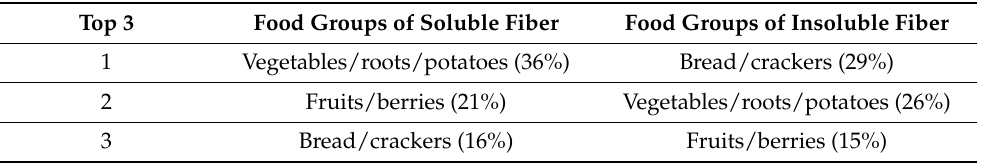
Table 5. Top three food groups that contributed the most to soluble- and insoluble fiber intake from registrations in the mobile phone application ( n =